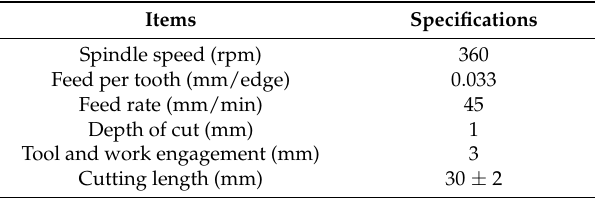
Table 3. Cutting conditions applied during machining.